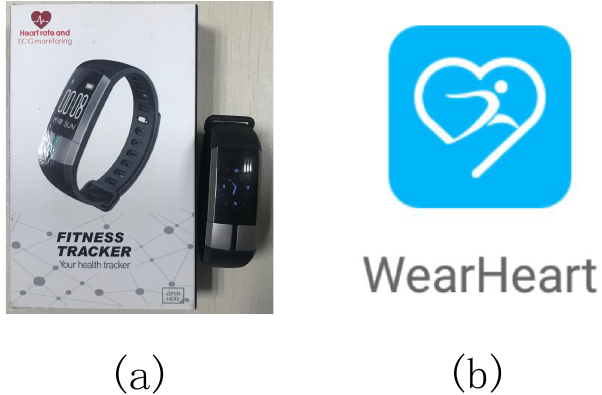
Figure 8. Example of a smart wristband. ( a ) The wristband. ( b ) App of clients.